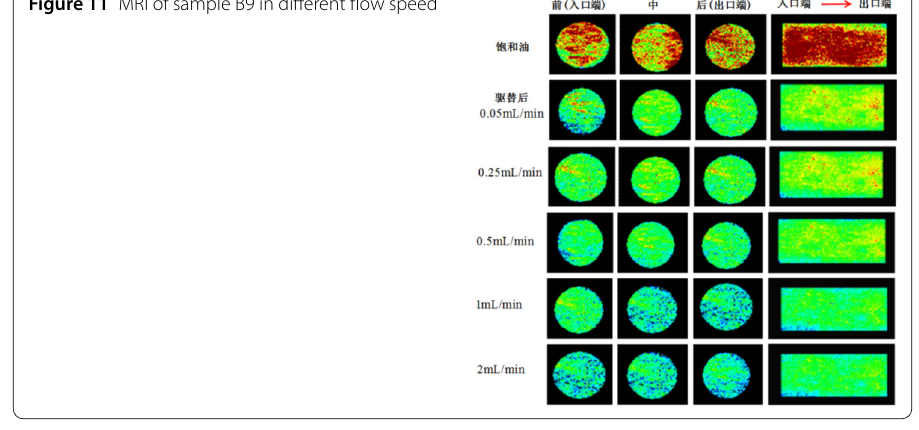
Figure 11 MRI of sample B9 in different flow speed